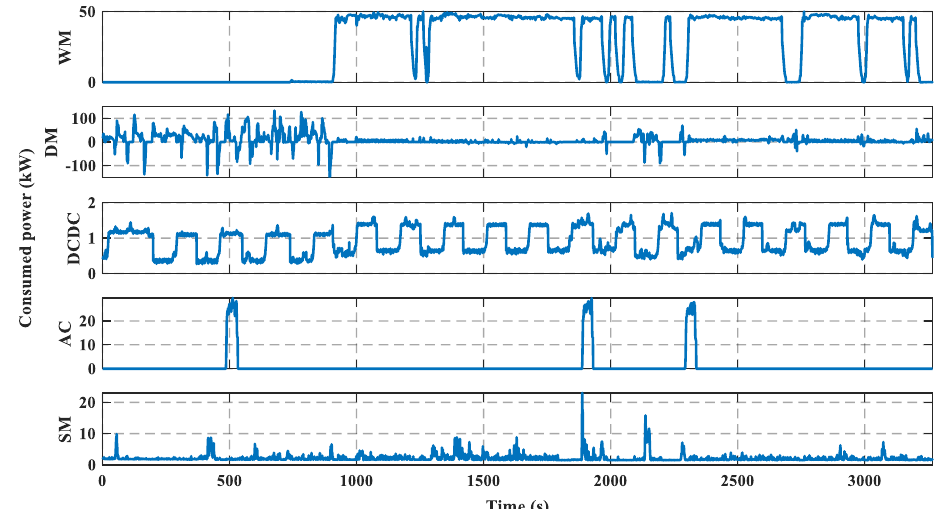
Figure 4. Electricity consumption of principal devices.